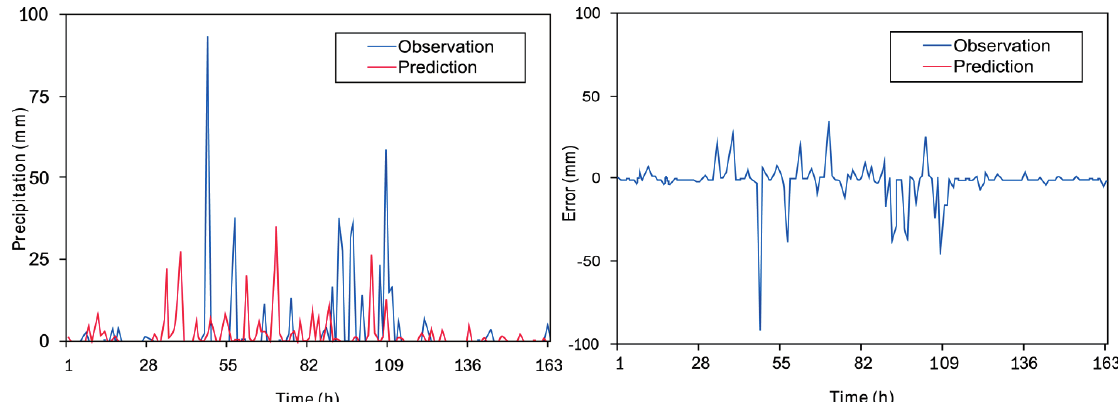
Figure 9. Evaluation of GEFS ensemble